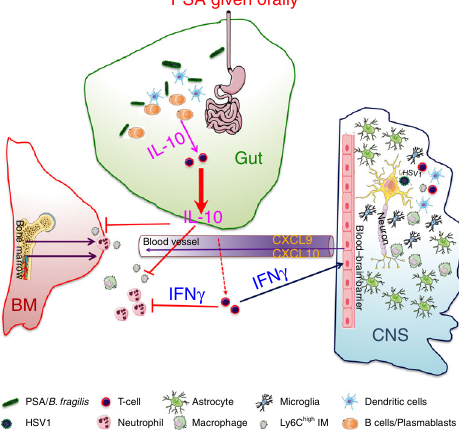
Fig. 7 Role of the bacterial symbiosis factor PSA in preventing viral encephalitis. HSV infection of susceptible 129 WT mice provokes excessive production of neutrophils (PMN) and Ly6C high in fl ammatory monocytes (IM) in the bone marrow that invade the brainstem in massive numbers resulting in fatal HSV encephalitis (HSE), despite antiviral treatment from day 4 pi. The bacterial symbiosis factor, PSA given orally is bound by B cells/CD138 + plasmablasts (PB) in the small intestine, which induces IL-10 and IFN γ production by regulatory CD4 and CD8 T cells resulting in the suppression of pathogenic in fl ammatory myeloid cells concomitant with the induction of IFN γ inducible chemokines in the BS. This novel study reveals the immunomodulatory potential of PSA in protecting from lethal viral infections of the CNS in combination with an antiviral. Cells involved in this protective mechanism are shown in the key. Inhibitory pathways indicated by red blocking